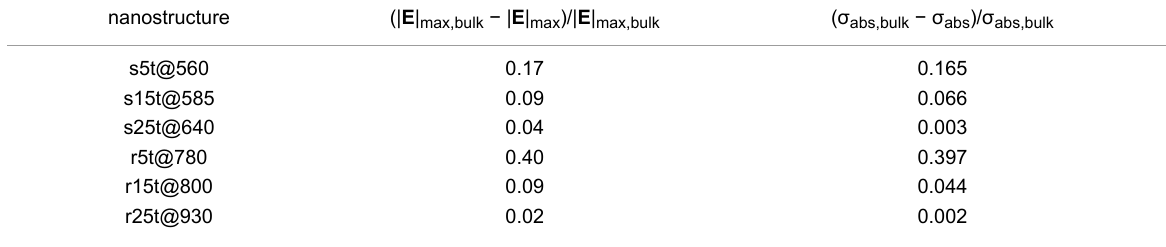
Table 2: The effect of including the size-corrected dielectric function of gold compared to using the bulk dielectric function of gold on the maximum near-field enhancement, (| E | max,bulk − | E | max )/| E | max,bulk , and absorption cross-section, ( σ abs,bulk − σ abs )/ σ abs,bulk for a gold nanosphere trimer and a gold nanorod at the longitudinal plasmon-resonance